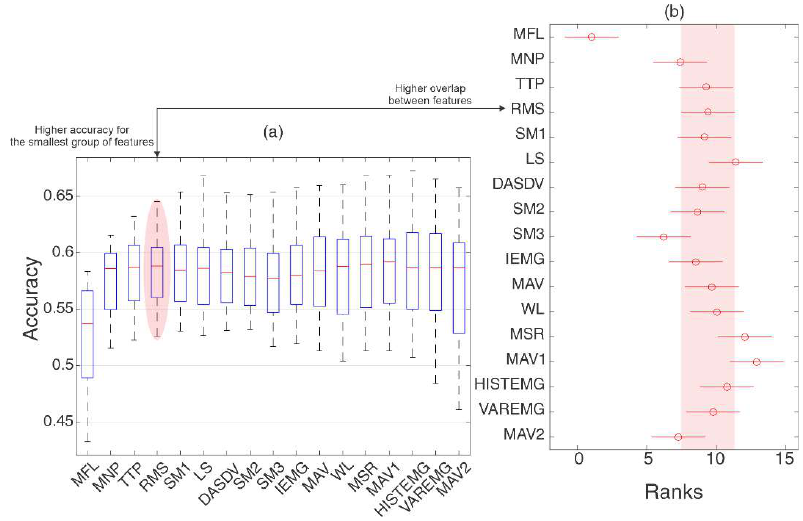
Figure 6. The selection process of the features from G6 to G9. The boxplot in ( a ) presents the distribution of accuracies increasing the number of features of G6 (from the highest to the smallest hit rate obtained separately) for the best classifiers (ELM, KNN, RF, and SVMRBF). The bars represent the 25 th and 75 th percentiles; the whiskers represent approximately 99.3% of the coverage of distribution, and the central mark represent the medians. ( b ) Distributions for the Tukey post-hoc from Friedman statistical test to evaluate the distribution of results with a confidence interval of 95% (p-value < 0.05) when increasing of the number of features in the classification process. The highlight indicates the distribution that is related to high accuracy obtained with a reduced number of features in (a) that corresponds statistically with the several distributions as demonstrated in (b).